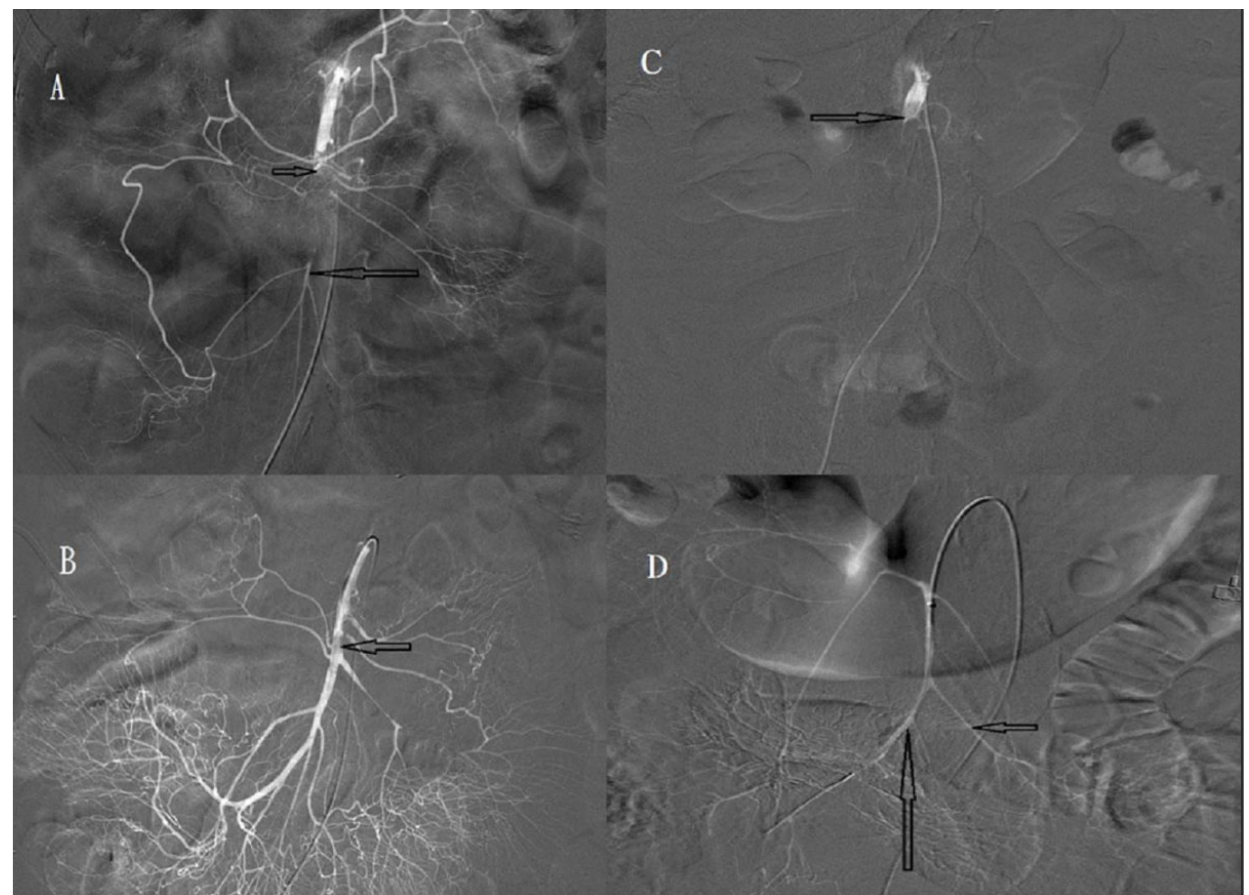
Figure 3. ( A ) Angiography of a 77 ‐ year ‐ old man, showing incomplete occlusion (short arrow) of the superior mesenteric artery (SMA). Distal main trunk of the SMA (long arrow) is visible. ( B ) Angiography obtained after one day of urokinase infusion, showing near ‐ total recanalisation of the SMA with appearance of the distal branches. The thrombus decreased in size, but remained (arrow). ( C ) Angiography of a 78 ‐ year ‐ old man, showing complete occlusion (arrow) of the superior mesenteric artery (SMA). Distal main trunk of the SMA is not visible. ( D ) Angiography obtained after 26 h of urokinase infusion, showing partial recanalisation of the SMA. The ileal artery (short arrow) and ileocolic artery (long arrow) are visible, but most of the jejunal arteries are not visible.